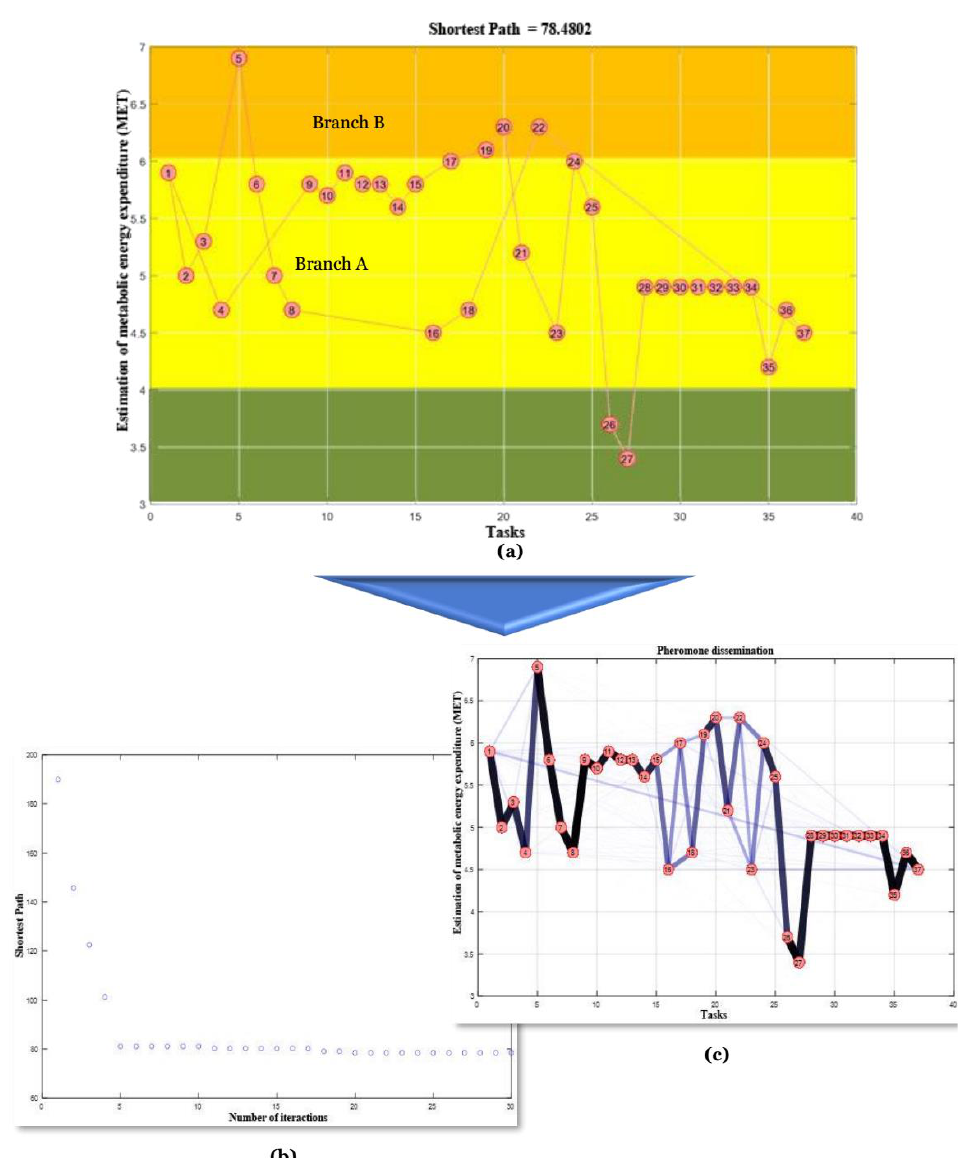
Figure 4. Graph representation of scenario 1. ( a ) Solution for optimizing the planning of production activities for the high season (during the harvest) with the various levels of metabolic energy expenditure in METs. ( b ) Evolution of the shortest path minimization process. ( c ) Dissemination of pheromones in the different paths along with the iterations.